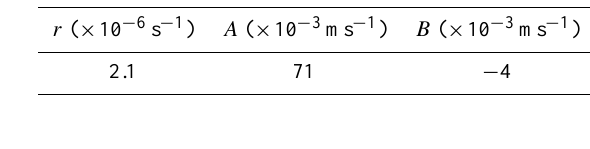
Table 3. Parameters of Eqs. (30) and (31) that best fit the numerical